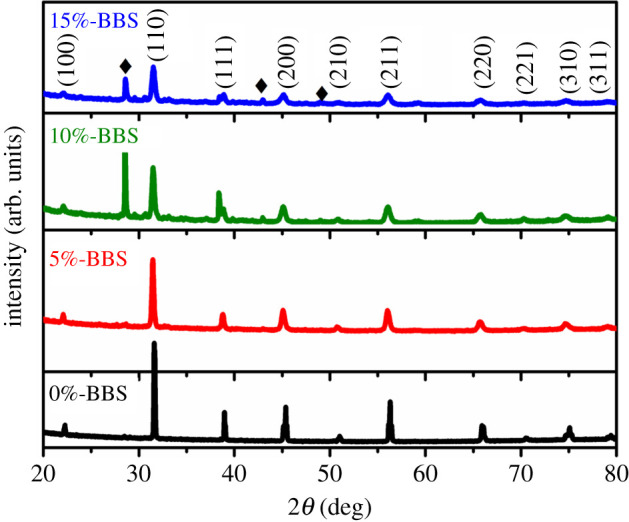
XRD patterns for the (1 − x)BCZT-xBBS ceramics (x = 0, 0.05, 0.1, 0.15).